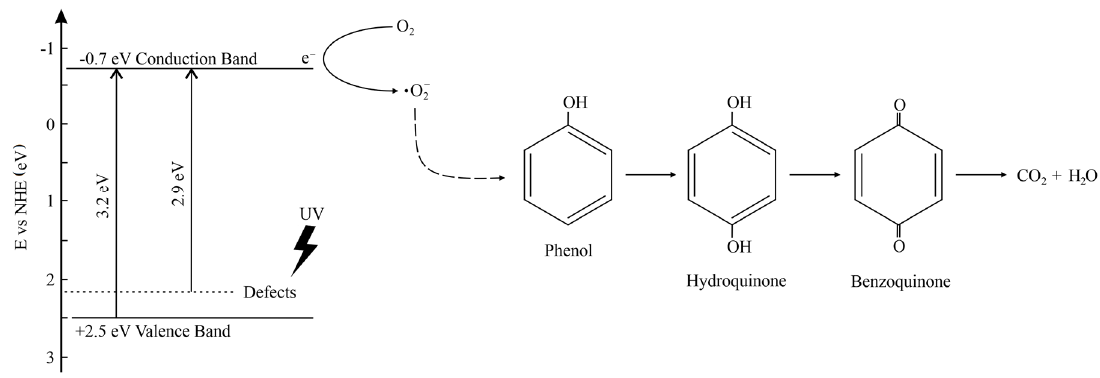
Figure 6. Schematic illustration of phenol degradation mechanism in the presence of defective TBT-HIO 3 photocatalyst.